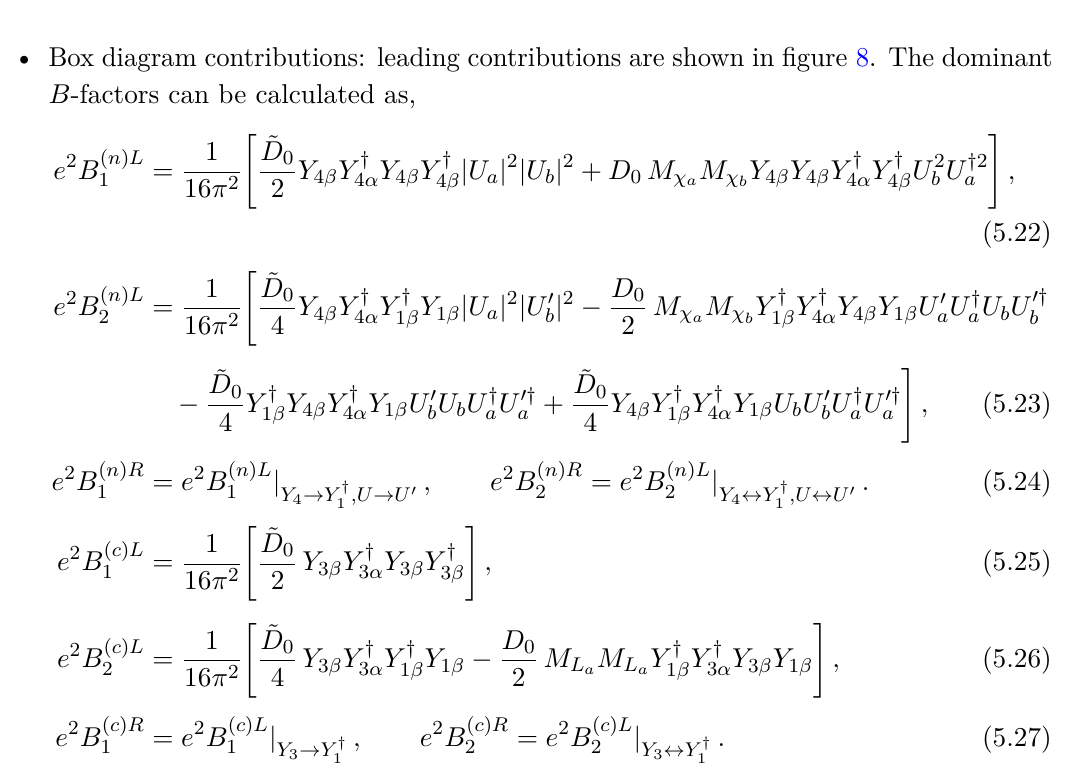
Figure 8 . Box diagrams contributing to the ‘ − 0 , 1 (for χ